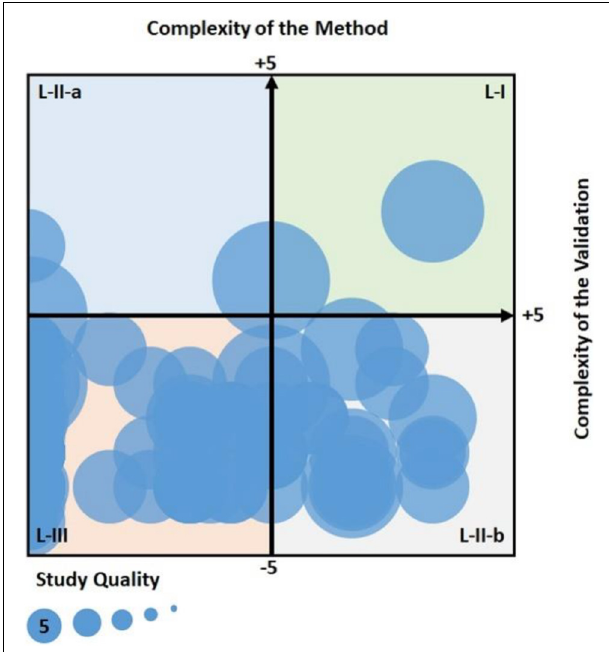
FIGURE 6 | The study groups in according to the complexity of the validation, the complexity of the method, and the study quality.